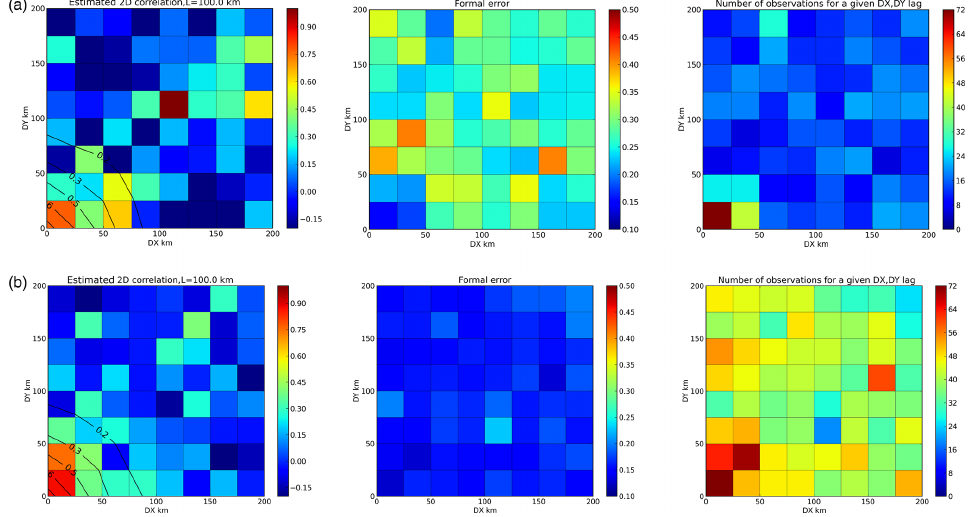
Figure 1. (a) Estimated 2-D covariance fields for the L = 100km simulation for the 2005 Argo sampling (left), associated formal errors (middle) and number of observation pairs (right). (b) Estimated 2-D covariance fields for the L = 100km simulation for the 2013 Argo sampling (left), associated formal errors (middle) and number of observation pairs (right).